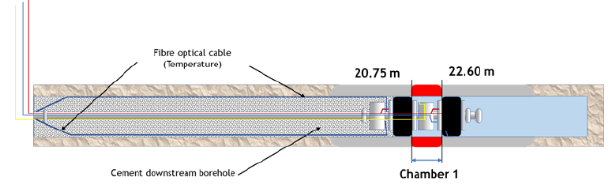
Figure 3. Scheme of the injection chamber that is about to be in- stalled in BH1.